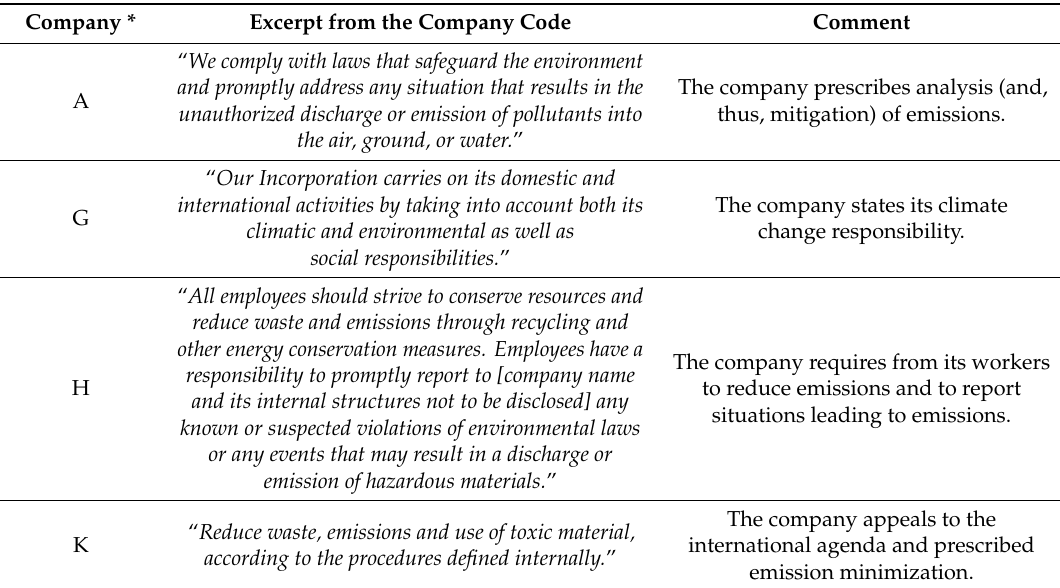
Table 3. Excerpts from the codes of the airline companies focusing on the climate-friendly